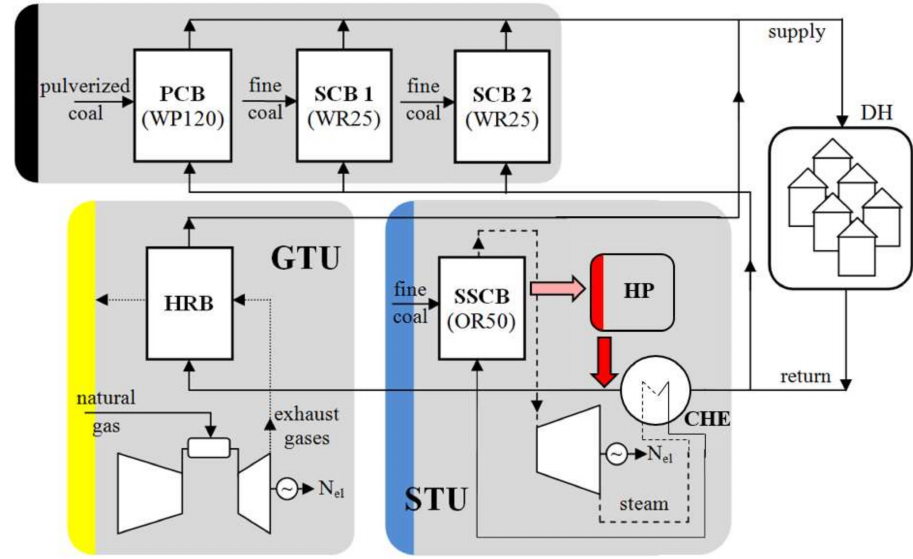
Figure 12. Schematic diagram of the proposed configuration of analyzed DH plant retrofitted with heat pump (HP) system recovering heat from coal stoker-fired steam boiler (SSCB) slag.